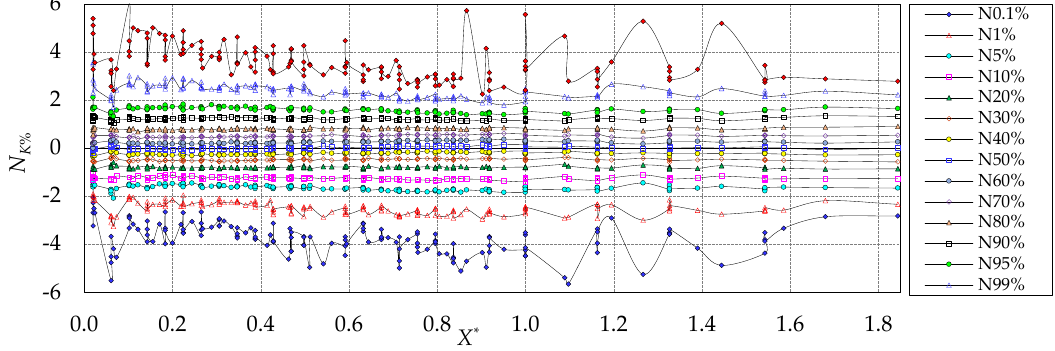
Figure 8. Distribution of the experimental values of the N K% coe ffi cient along basin II .